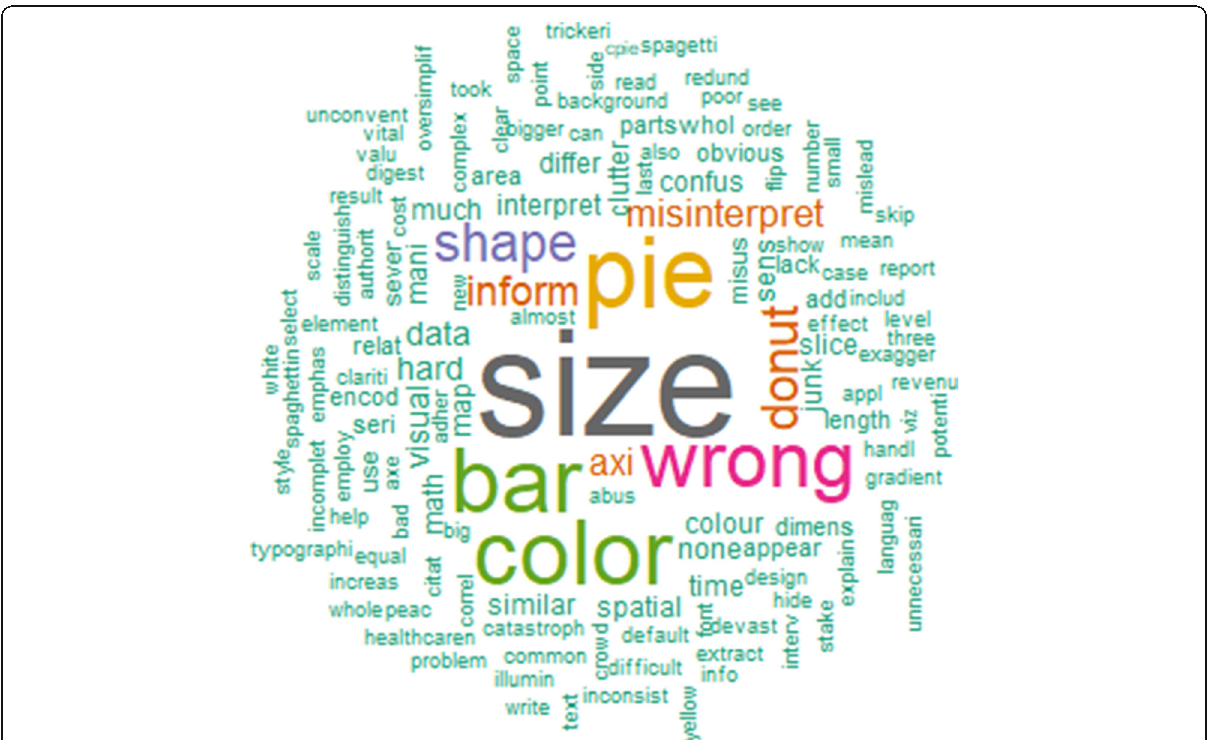
Fig. 3 Word cloud constructed from associated descriptions about the figure that encounters visualization